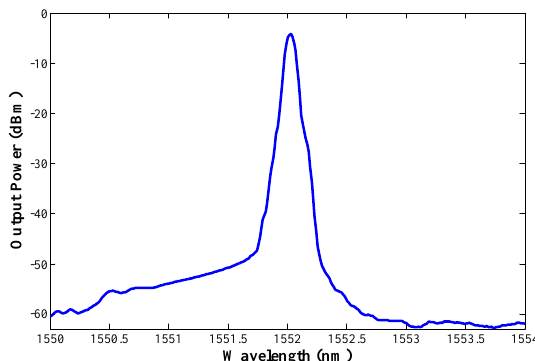
Figure 6. Output spectra measured by the OSA when using 2 m of EDF M12.